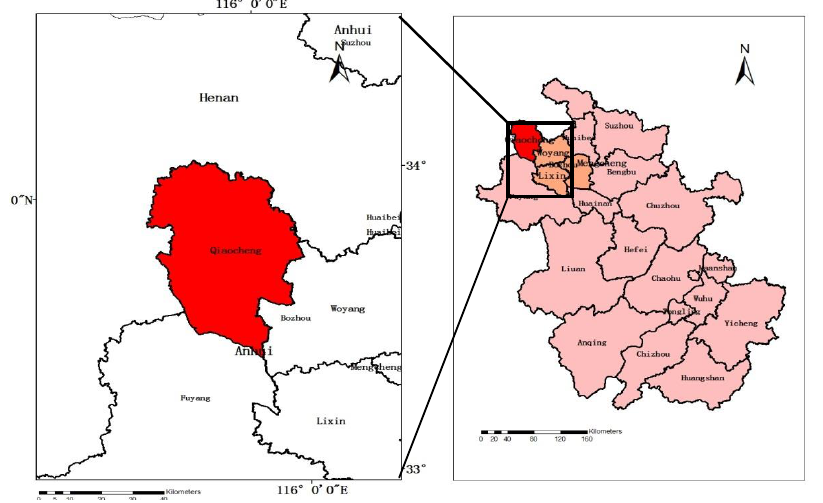
Figure 1.The geographical location of the study